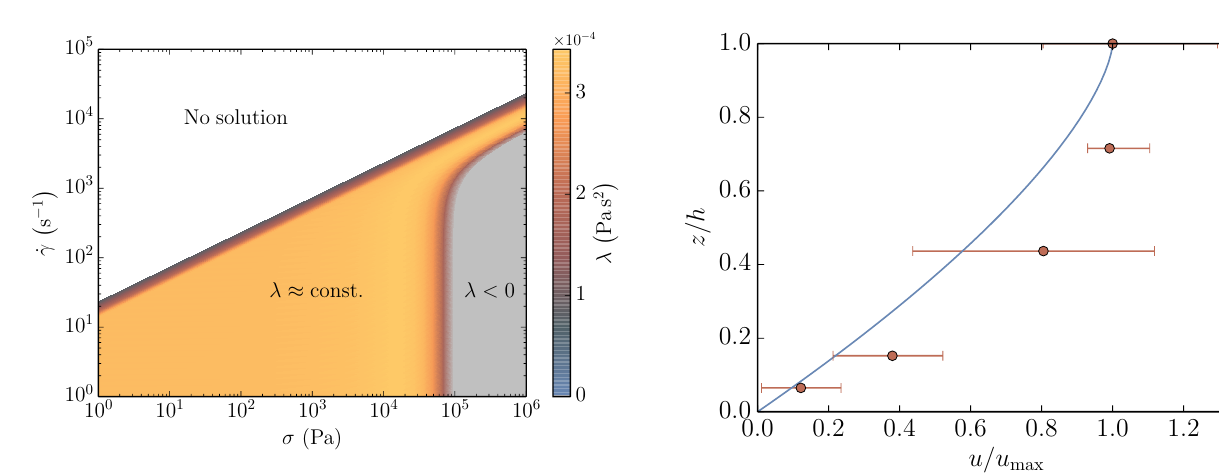
Figure 12. Velocity profile for an infinite avalanche in steady state on a uniformly steep slope for the given rheology model (blue line). For comparison, velocity measurements of a dry snow avalanche from a field test in Vallée de la Sionne is shown (red filled circle is the mean velocity; bars are fluctuations) (data from Kern et al., 2009; Sovilla et al., 2015). The measurement shows a more bulbous velocity profile, which indicates a plug flow regime. The bars show the high fluctuation of velocity of grains, which agrees with the as- sumptions of the kinetic